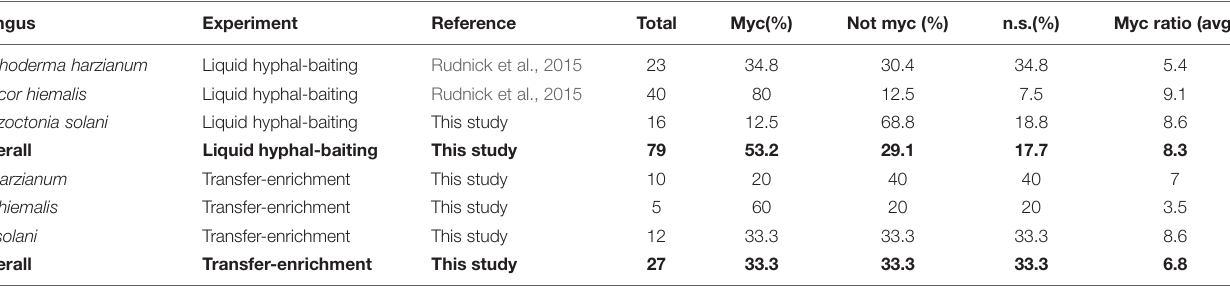
TABLE 1 | Occurrence of mycophagy among sequenced bacteria that adhered to fungal hyphae and were scored antifungal in the confrontation